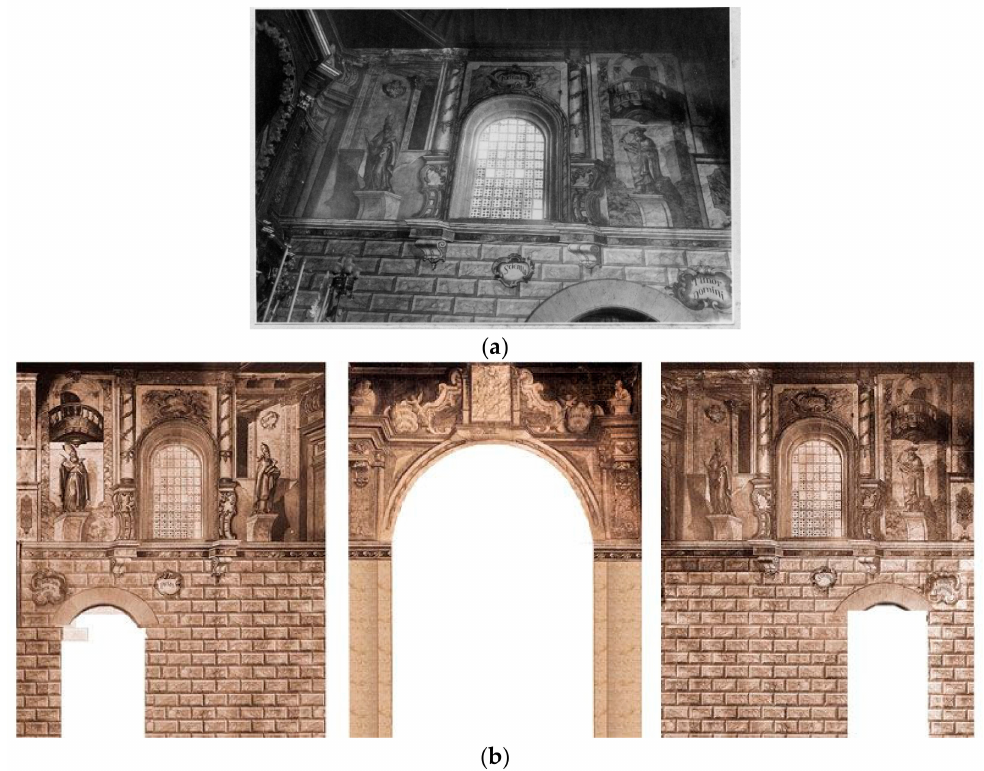
Figure 6. ( a ) Antique photo of the lateral facing situated to the left of the altar. Source: Universidad de Sevilla. ( b ) Reconstruction of the presbytery using antique photos. Source: Cor-Ignis